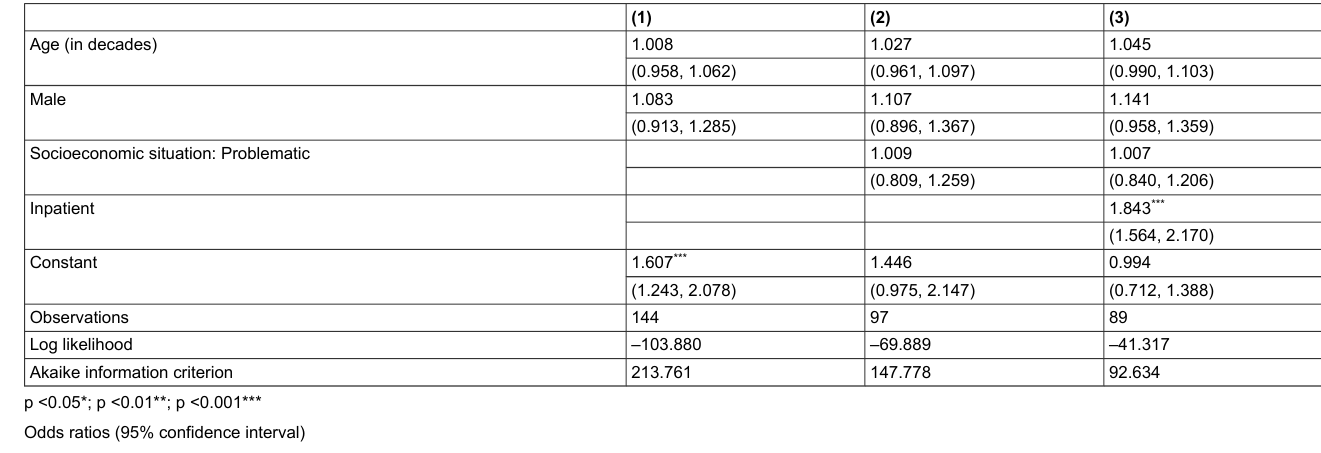
Table 3: Logistic regressions on the response: “Last contact = in less than 24